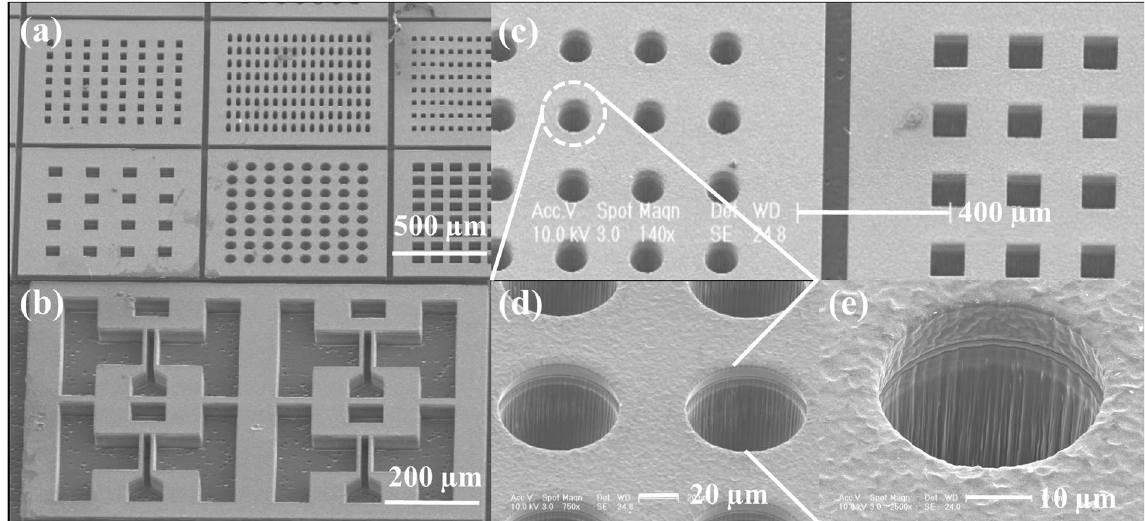
Figure 2. SEM images of various via-holes formed on a SiC substrate using optimized parameters for the ICP- RIE technique. ( a ) Mask opening widths of 35 µ m, 25 µ m, 20 µ m, 100 µ m, 70 µ m, 70 µ m (from the top left, row first). ( b ) Vertically etched SiC with a complicated pattern and a well-etched sidewall profile. ( c ) Mask opening width of 70 µ m (circular) and 70 µ m (square), from left to right. ( d ) Circular pattern enlarged five times. ( e ) Circular pattern enlarged ten